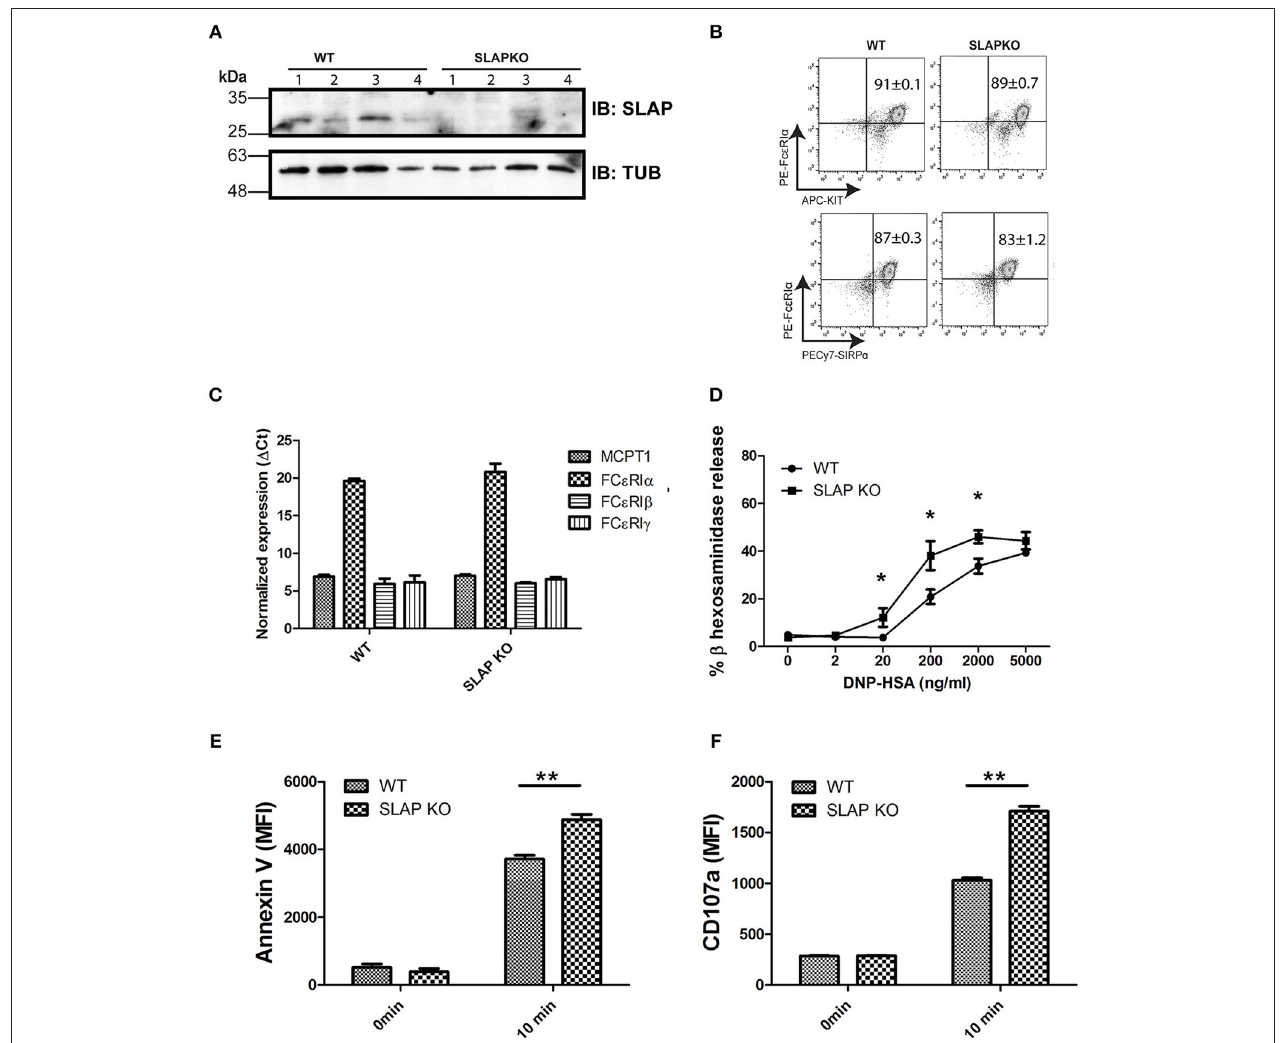
FIGURE 1 | Mature SLAP KO BMMCs show enhanced degranulation upon antigen stimulation. (A) Lysates were prepared from WT and SLAP KO BMMCs derived from four different mice and subjected to immunoblotting (IB) with SLAP and Tubulin (Tub) antibodies. Positions of relative mass markers (in kilodaltons) are shown on the left. (B) WT and SLAP KO BMMCs were stained with antibodies against cell surface receptors Fc ε RI α , KIT, and SIRP α . Numbers in dot plots show the mean ± SD values of % double positive (Fc ε RI α + , KIT + ) or (Fc ε RI α + , SIRP α + ) of the total cells. Results are from a representative experiment done in triplicate out of